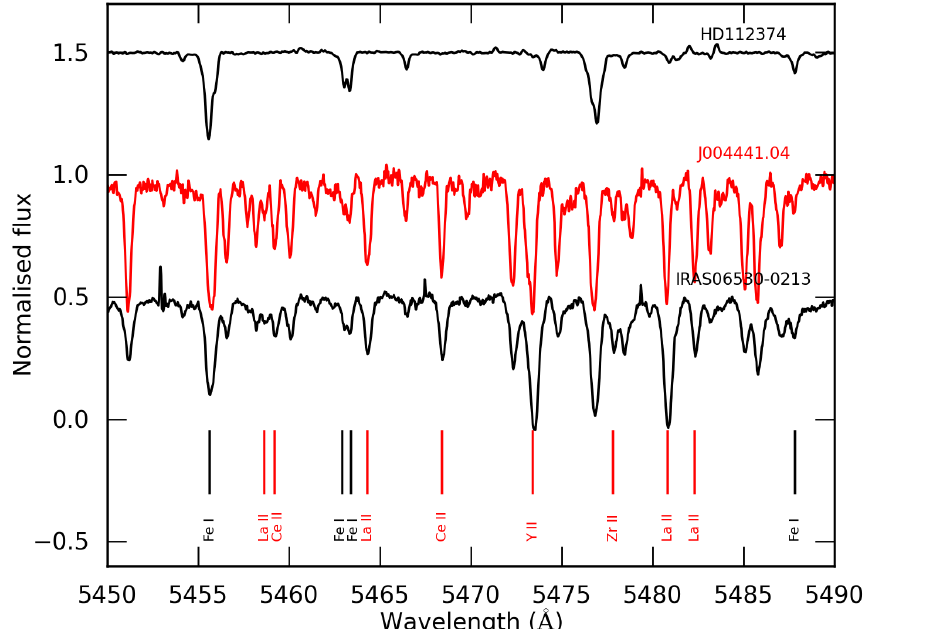
Figure 3. Spectral comparison of three stars with similar temperatures and overall metallicity. Only the top spectrum is from a star without s -process enhancements. In very enriched objects (i.e., the bottom two spectra), the s -process lines almost dominate the spectral appearance. Figure from